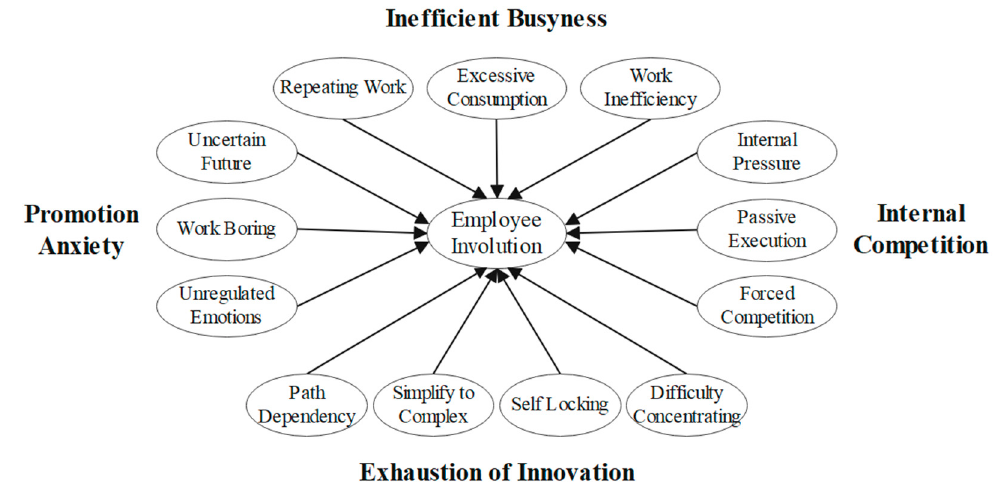
Figure 1. Involution Impact Factor Model.